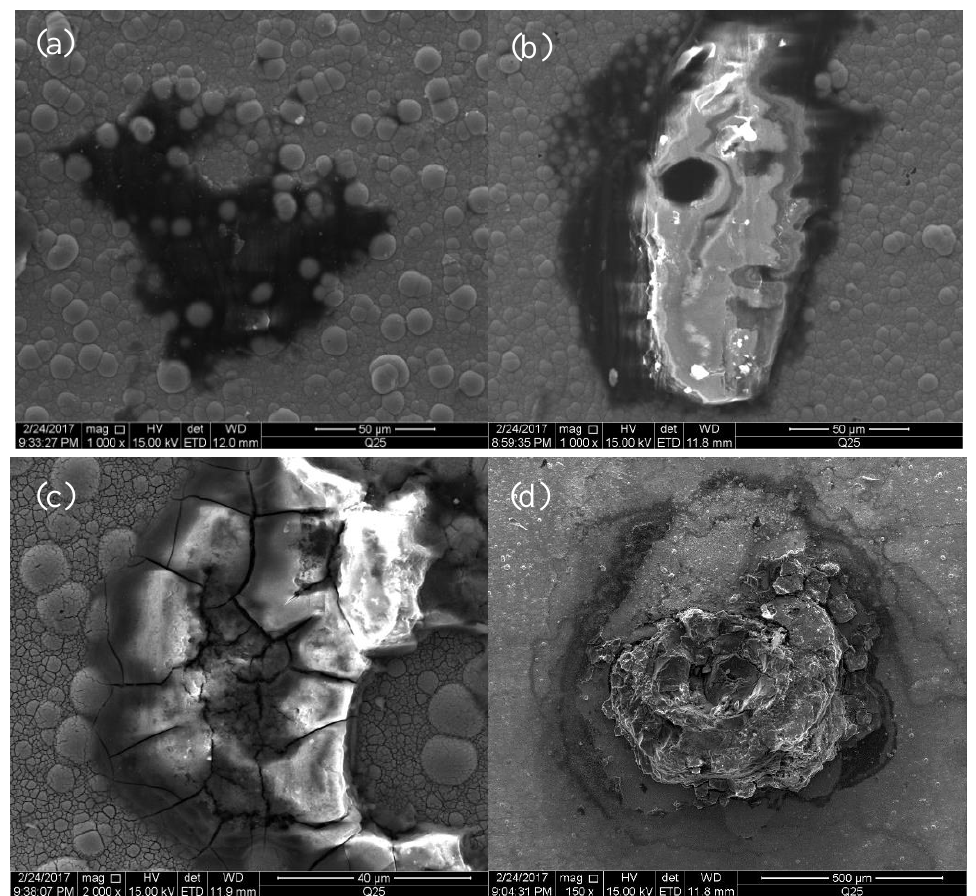
Figure 7. Representative SEM images showing evolution in surface morphology of the annealed NPC/Phosphate during immersion test ( a ) passivation layer formation; ( b ) coating surface corrosion, ( c ) substrate corrosion, and ( d ) an etch pit.